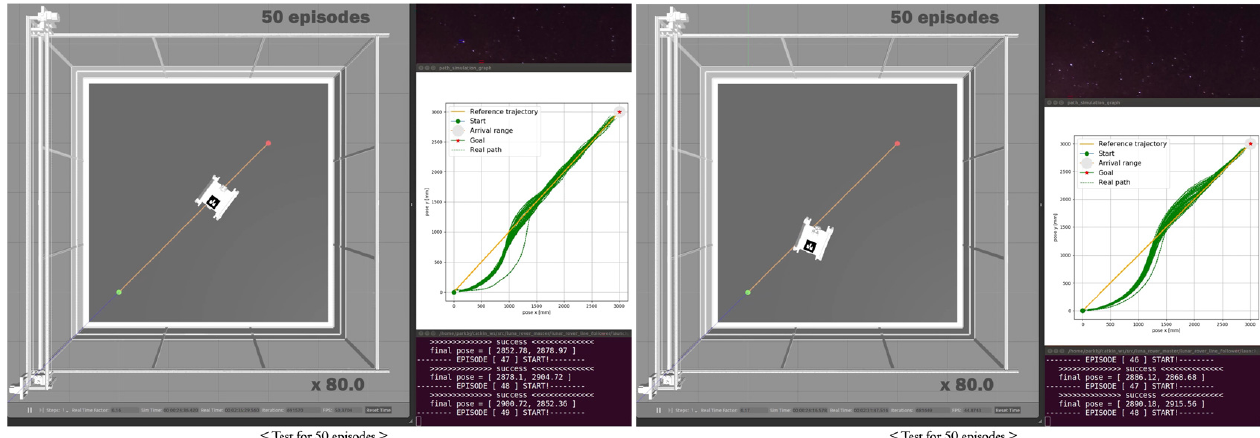
Figure 22. Averaged actual paths and perpendicular position error from the optimum reference trajectory obtained through repeated experiments on motion planning with the DQN.